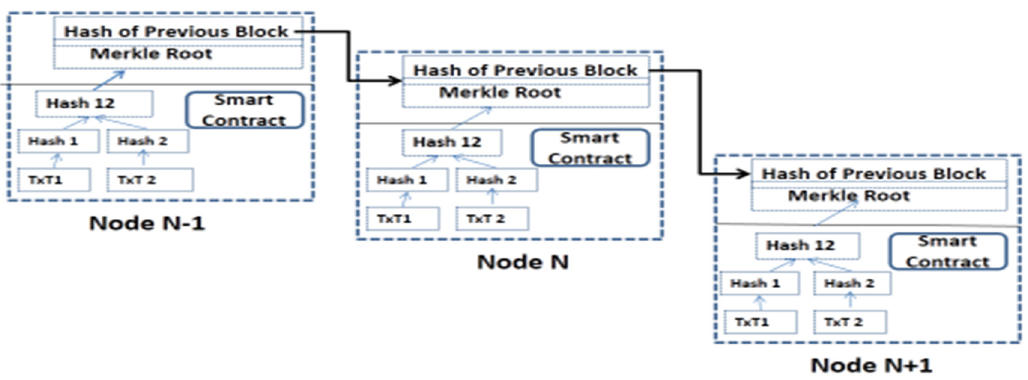
Figure 3. Structure of blockchain.